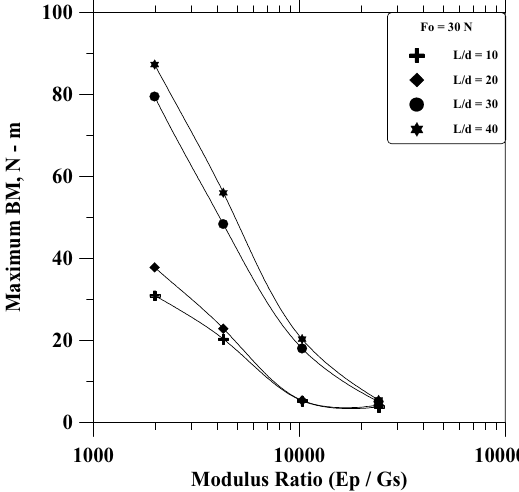
Fig. 18. Variation of maximum dynamic BM of piles with modulus ratio at F 0 = 30